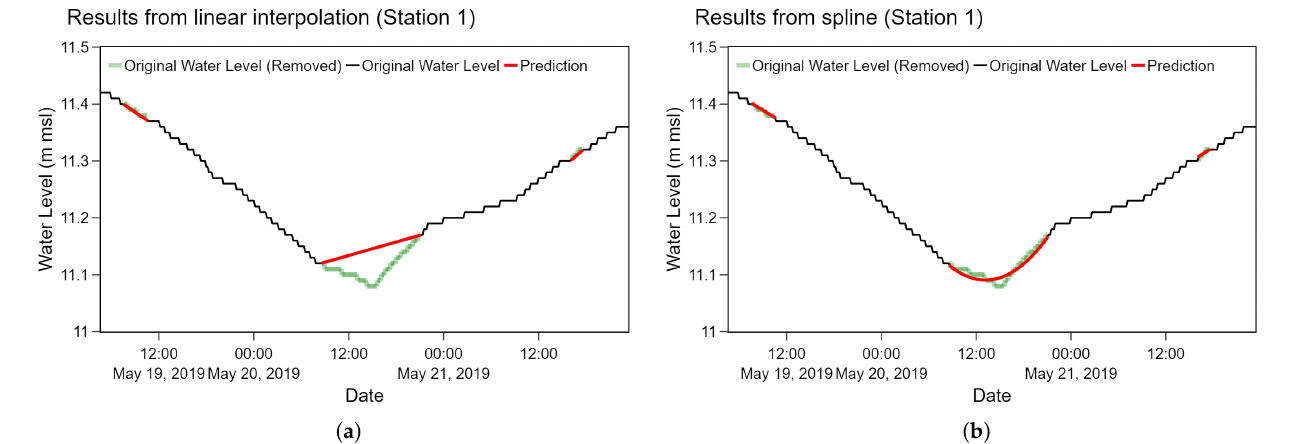
Figure 11. A result comparison between ( a ) the linear interpolation and ( b ) the spline method applied on parts of time series obtained from station